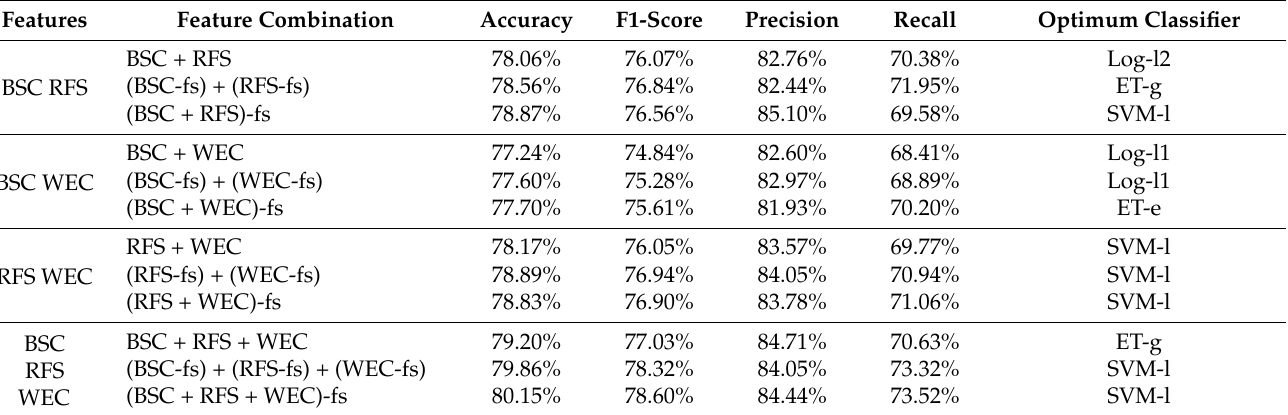
Table 4. Optimal model performance of multidimensional